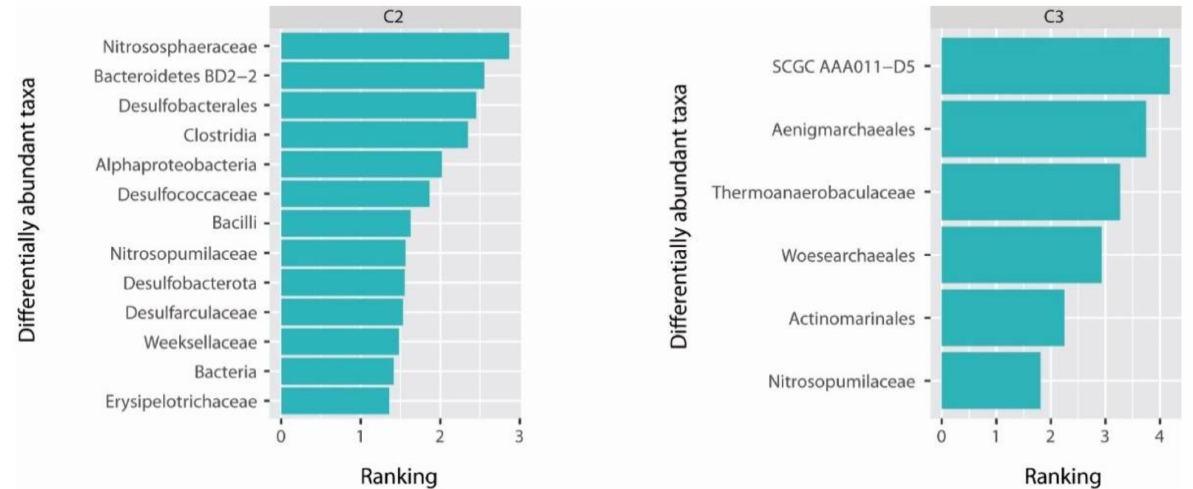
Figure 5. Results of Songbird analysis including top 20% of differentially abundant taxa at family level associated with samples from clusters C2 and C3 with samples from cluster C1 as